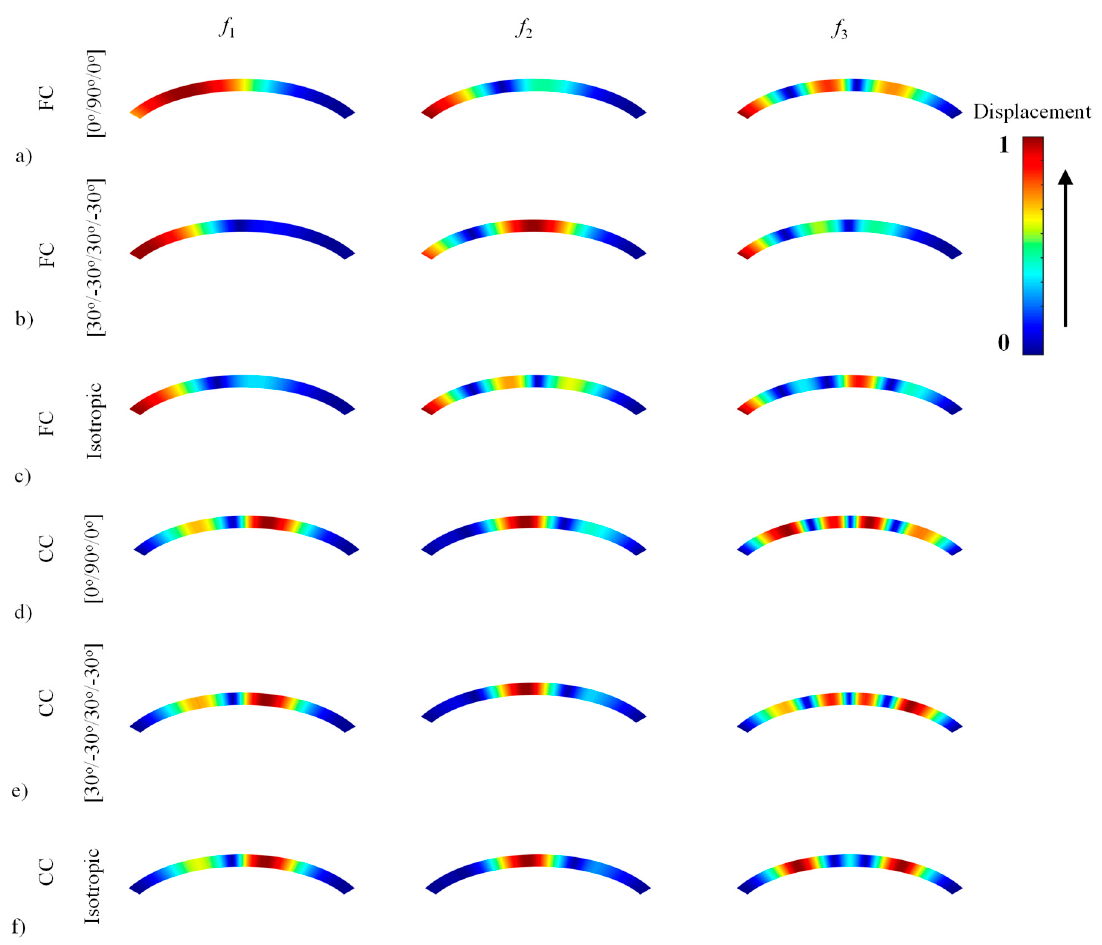
Figure A1. Several mode shapes for an elliptical composite laminated beam and an elliptical isotropic beam.